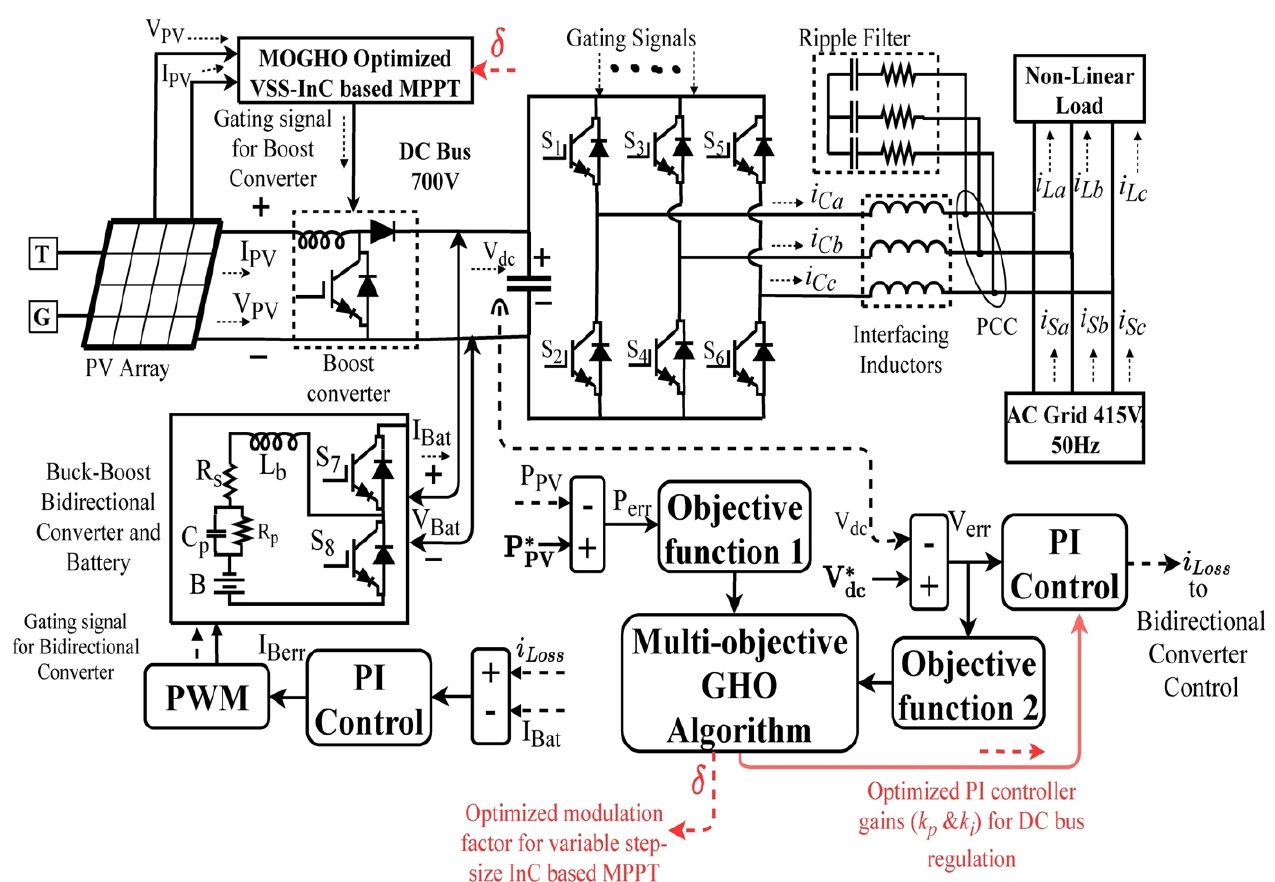
Figure 1. Proposed topology.